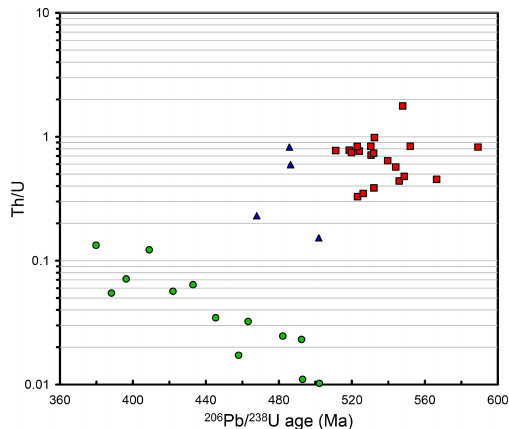
Figure 15. Weighted average obtained from magmatic ages dis- tributed between 589 and